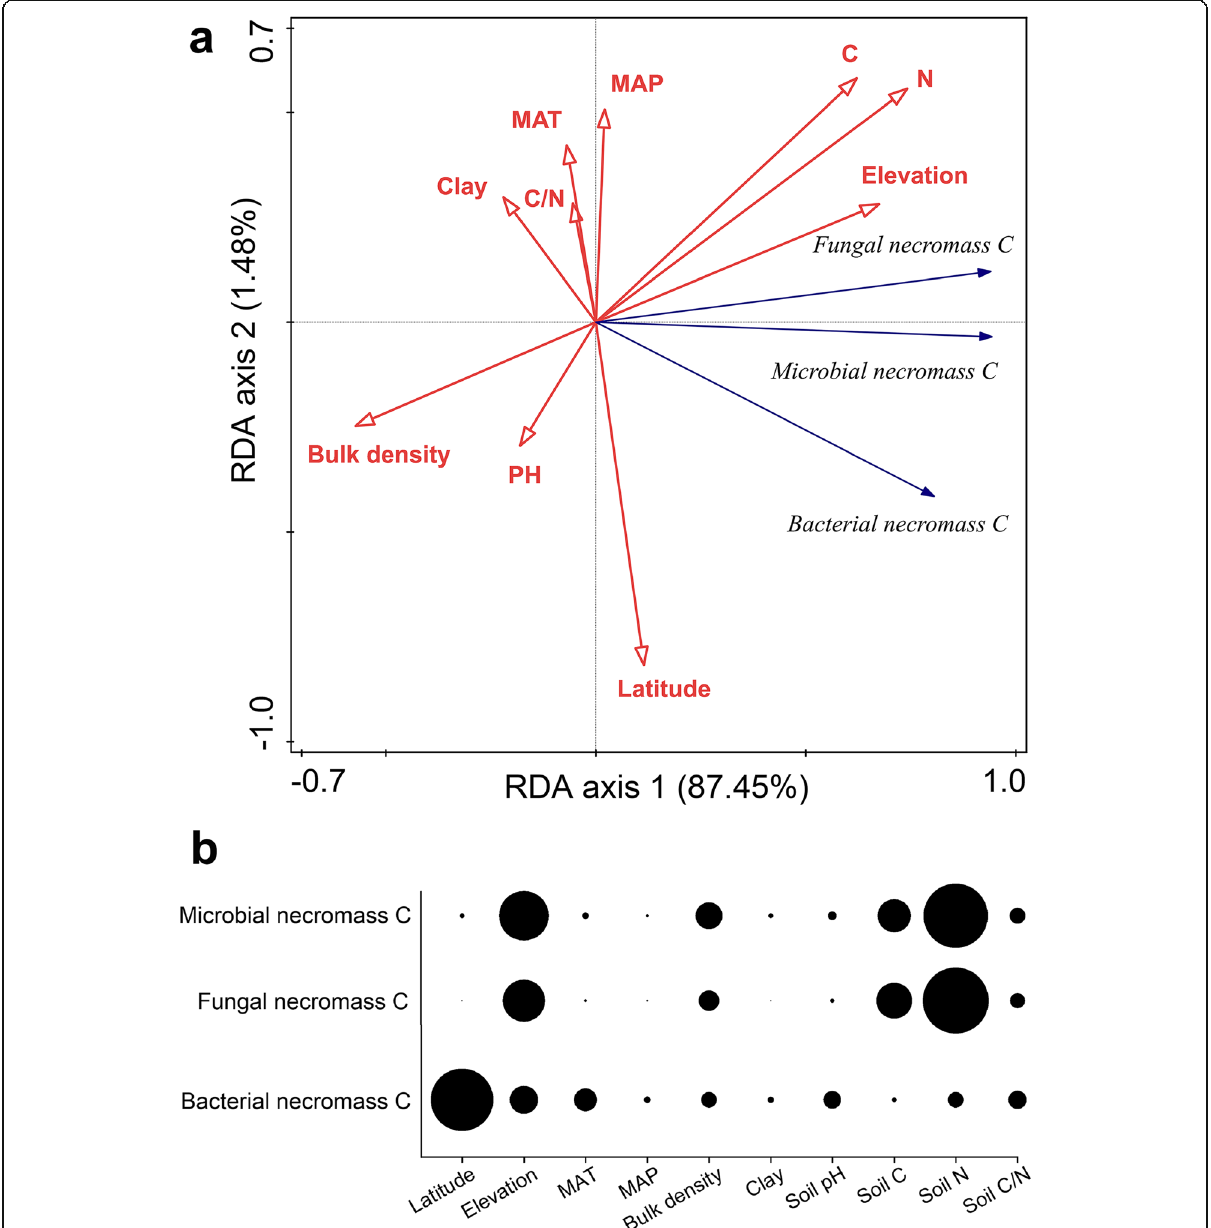
Fig. 7 a Ordination biplot of the redundancy analysis (RDA) on microbial necromass C and geochemical variables. The variances explained by geochemical variables are shown on axes 1 (87.45%) and 2 (1.48%), respectively. The explanatory variables are indicated by different arrows: microbial necromass C by blue arrows and geochemical variables by red arrows. Arrows with narrow angles (< 90°) are positive correlations, and arrows in opposite directions (> 90°) show negative correlations. b The relative importance of geochemical variables to microbial necromass C. All variables were collected at the control plots (without N addition) at the 11 sites at which the microbial necromass C data were obtained. The circle size is proportional to the variable importance values (the importance of variance explained) based on partial least square regressions within each row. The most important variable has the largest circle, but the circle size is comparable only within a row. The adjusted R 2 values are 0.882, 0.848, and 0.746 for total microbial, fungal, and bacterial necromass C, respectively (all n = 118). MAT, mean annual temperature; MAP, mean annual precipitation; C, carbon; N, nitrogen; C/N, soil carbon to nitrogen